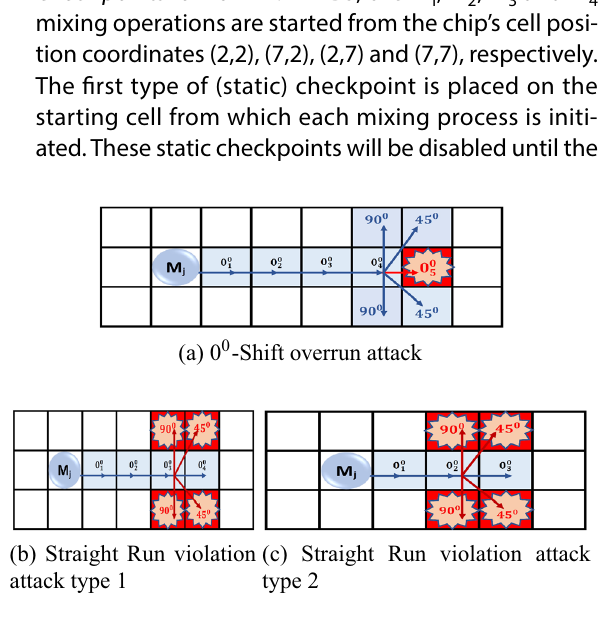
Fig. 17 Different types of violation attacks on RBS method